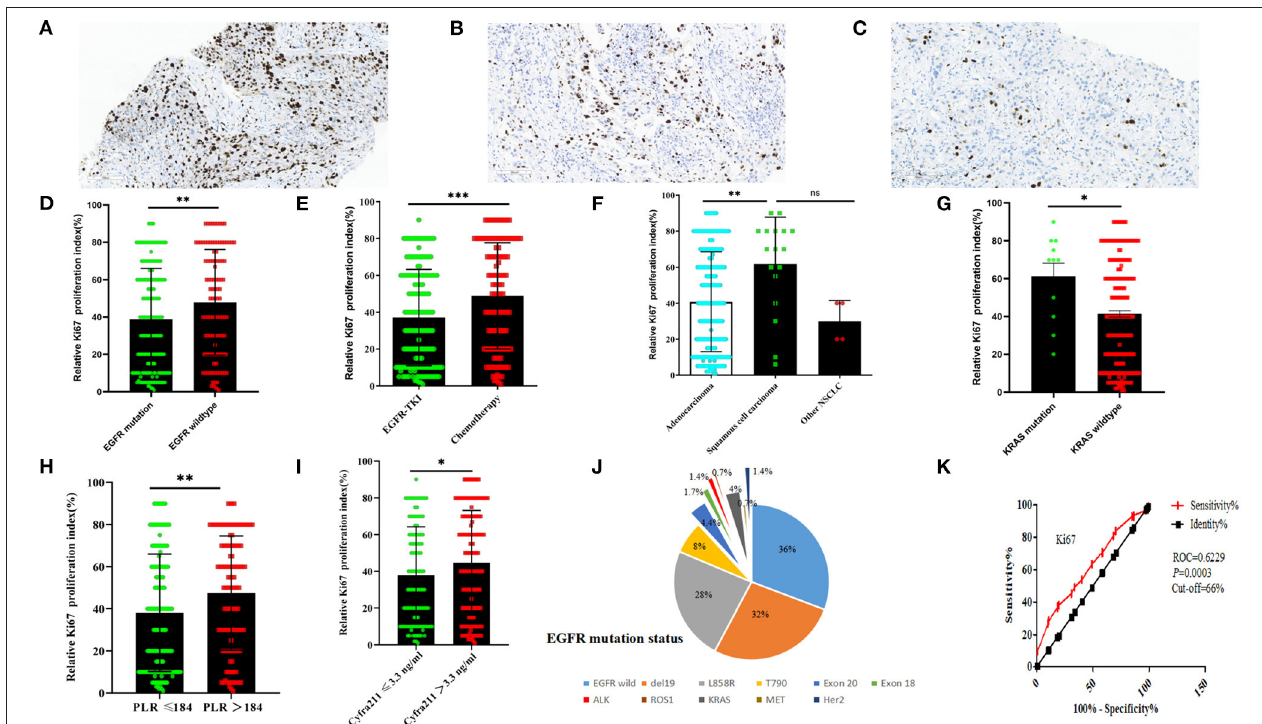
FIGURE 2 | The immunohistochemistry of Ki-67 proliferation index and the relationship between clinical-pathological features in NSCLC. The immunohistochemistry of Ki-67 proliferation index was 85% (A) , 50% (B) , and 8% (A) (scale bar = 100 µ m); The EGFR-mutant status (D) , treatment regimens (E) , pathological types (F) , and KRAS-mutant status (G) , PLR ratio, (H) and serum Cyfra211 (I) relationship between Ki-67 proliferation index; (J) , the number of patients in NSCLC with EGFR-mutant status; (K) the Ki-67 curve of cutoff value (according to the treatment regimens in 295 NSCLC patients). EGFR mutation = del 19/L858R/T790M/Exon18/Exon 20 insertions, PLR = platelet-to-lymphocyte ratio, other NSCLC = adenosquamous carcinoma, large cell carcinoma and unclassified NSCLC. ( ns P > 0.05, * P < 0.05, ** P < 0.01, *** P < 0.001, mean ± SD, t -test). EGFR, epidermal growth factor receptor; NSCLC, non-small cell lung cancer; TKIs, tyrosine kinase